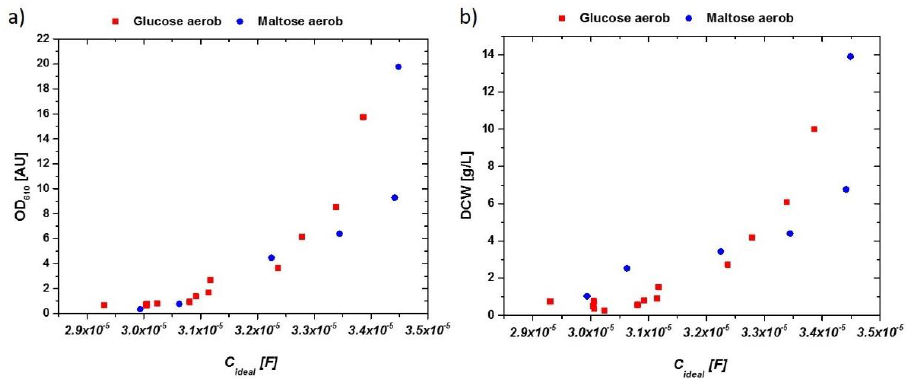
Figure 3. ( a ) OD 610 vs. extracted capacitance of the impedance signal in aerobic cultivations with glucose and maltose. ( b ) DCW vs. extracted capacitance of the impedance signal in aerobic cultivations. Very similar responses are obtained for both cultivations, irrespective of the used C-source.